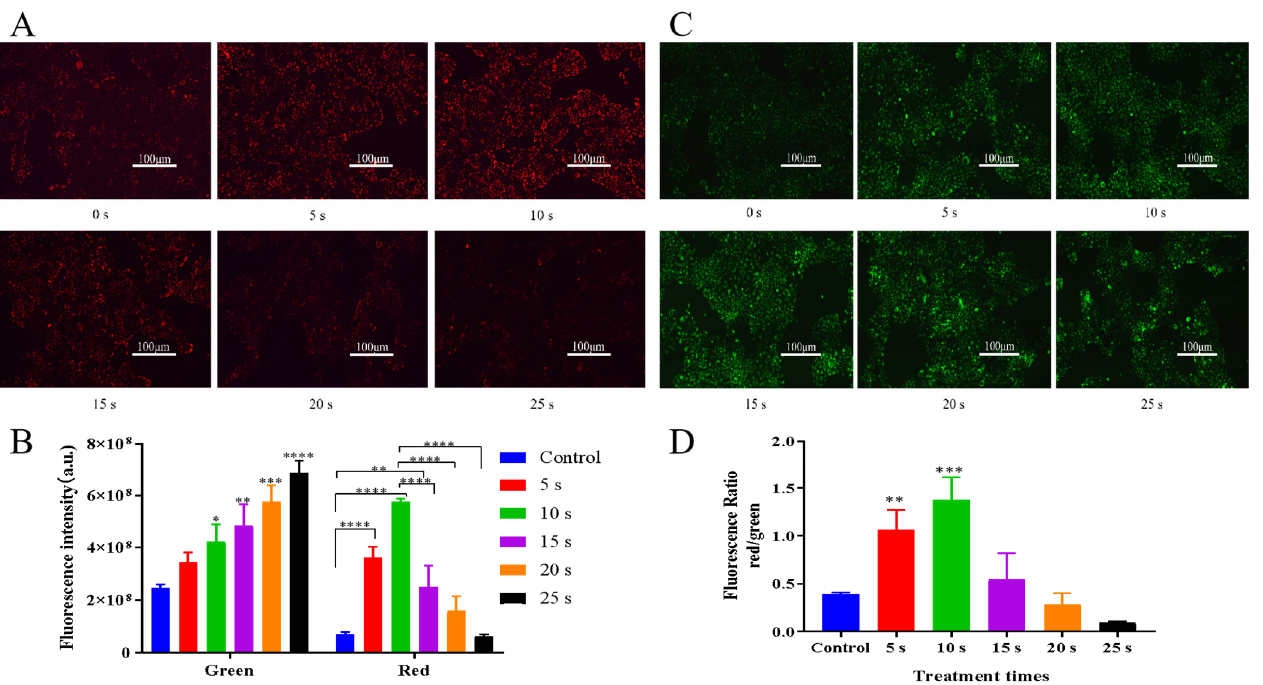
Figure 4. Mitochondrial membrane potential in HaCaT cells. ( A ) Red fluorescence image of mito- chondrial membrane potential in HaCaT cells. ( B ) Quantification was performed by measuring the intensity of red and green fluorescence pixels in HaCaT cells using Image J software. ( C ) Green fluorescence image of mitochondrial membrane potential in HaCaT cells. ( D ) The ratio of red to green fluorescent pixels was quantified using Image J software. Data represent the mean ± SD of three independent experiments. * p < 0.05, ** p < 0.001, *** p < 0.001, **** p < 0.0001 with ANOVA compared with the control.